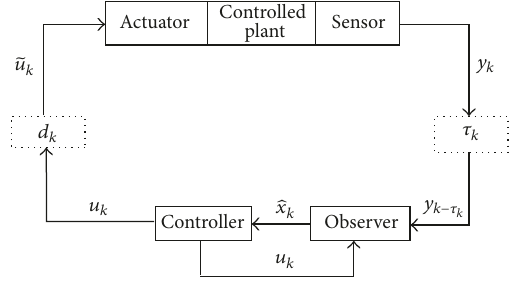
Figure 1: Diagram of the